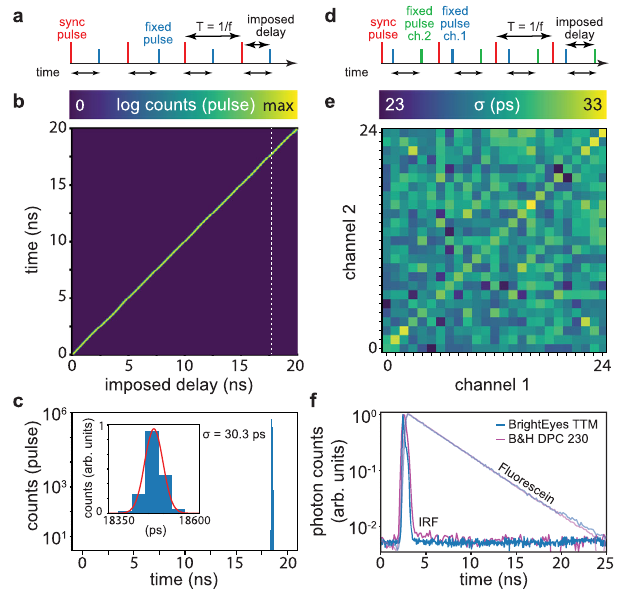
Fig. 2 | BrightEyes-TTM characterization and validation. a – c Single-shot preci- sion experiment. a Temporal schematic representation: a fi xed frequency SYNC clock signal and a synchronized but delayed (in a controlled way) signal. b Uni fi ed representationofthestart – stoptimehistogramsasafunctionoftheimposeddelay between the two signals. c Single start – stop time histogram for the delay denoted bythedottedwhitelineinthemiddlepanel.Theinsetshowsamagni fi cationofthe histogramforaselectedtemporalinterval,superimposedwiththeGaussian fi t(red line). d , e Dual-channel single-shot precision experiment. d Temporal schematic representation: a fi xed frequency SYNC clock signal and a pair of synchronized signals (channel A and channel B). The delays between all three signals are fi xed. e Jitter map for each pair of channels (here, 25 channels), i.e., error in the time- difference estimation between any two channels, measured as the standard deviation of a Gaussian fi t of the error distribution. The diagonal of the map represents the sigma of the single-channel single-shot precision experiment. f Normalized impulse-response functions (dark colors) and fl uorescein – water solution decay histograms (light colors) for the BrightEyes-TTM and DPC-230 multi-channel card. The instrument response functions (IRFs) represent the response of the whole architecture (microscope and DAQ) to a fast (sub-nanose- cond) fl uorescence emission. The full-width-at-half-max values are 250ps for the DPC-230 card and 200ps for the BrightEyes-TTM. The decay histograms are also typicallyreferredtoasstart – stoptimehistogramsorTCSPChistograms.Allsingle- channel measurements were done with TTM channel #12, which received the photon signal from the central element of the SPAD array detector. All start – stop histograms have 48ps granularity (bin